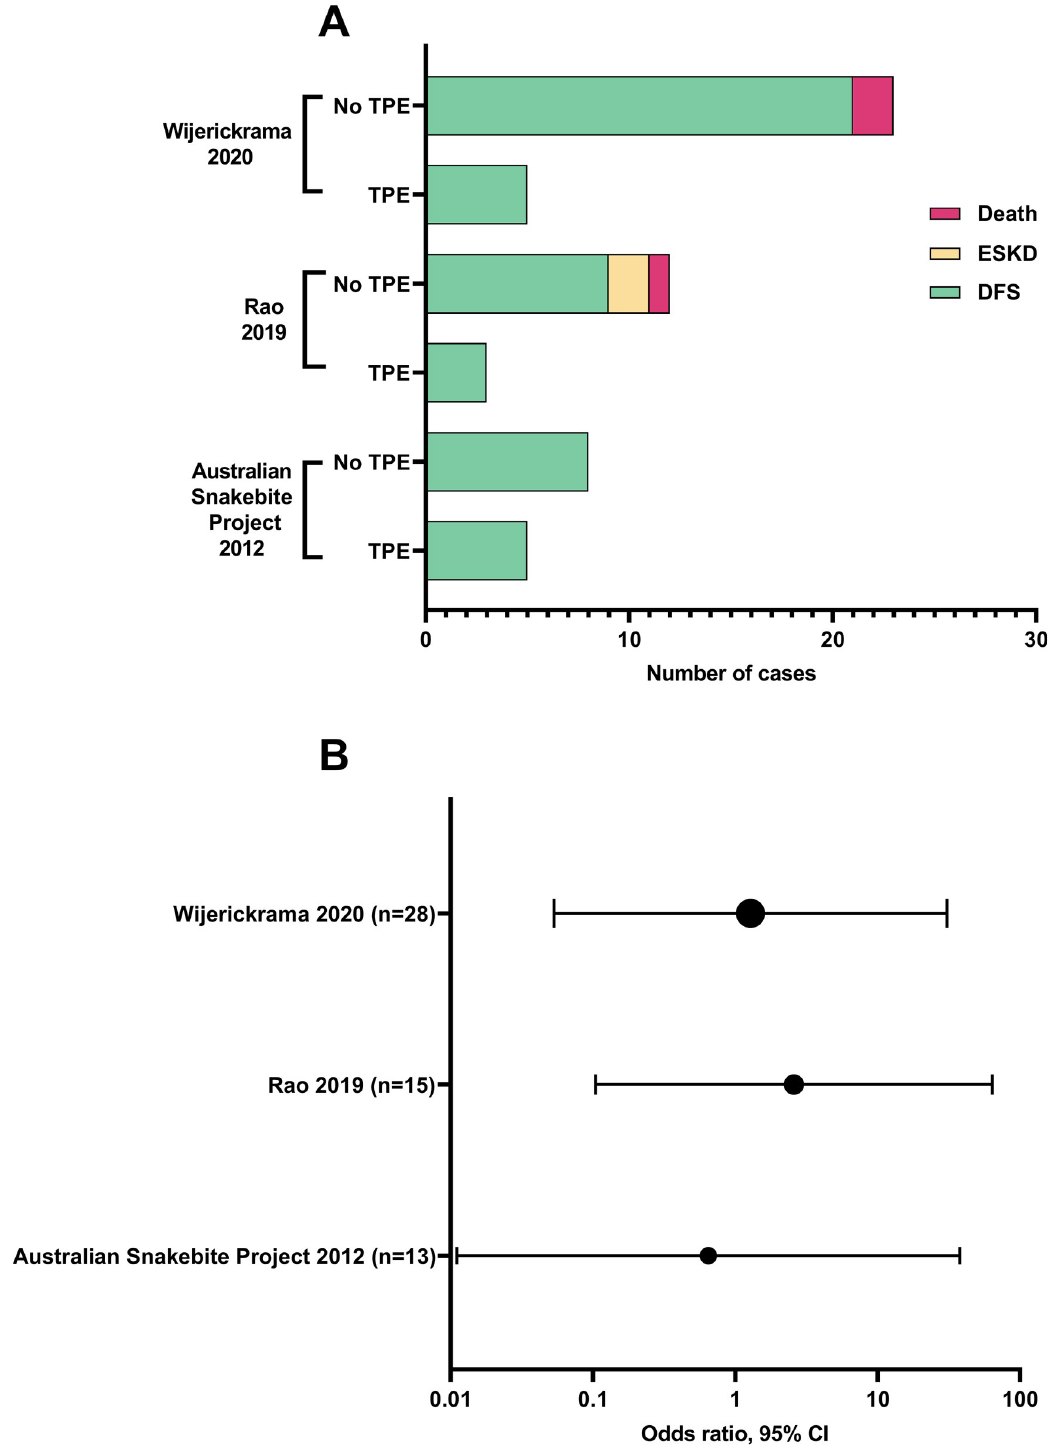
Fig 4. Dialysis free survival for plasmapheresis (TPE) versus non-TPE treated cases for studies with low risk of selection bias: (A) total number of cases; and (B) odds ratio of dialysis free survival (DFS) for TPE vs non-TPE. p > 0.05 for all calculated odds ratios. ESKD: End stage kidney